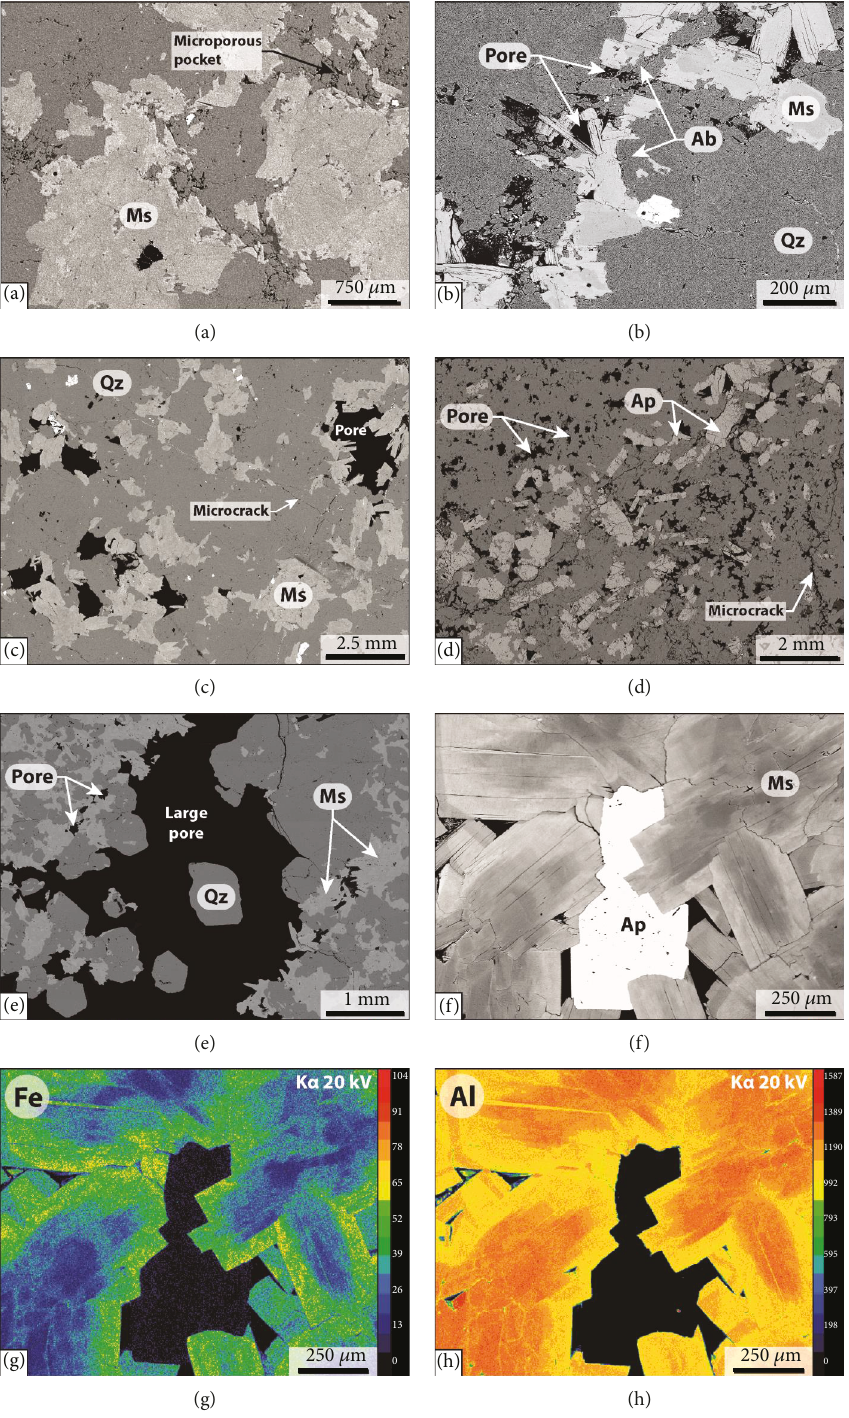
Figure 6: SEM-BSE images displaying the microtextural evolution induced by the greisenization of the Panasqueira granite. (a) Porous texture in a greisenized granite sample showing the heterogeneous distribution of the porosity. A microporous pocket and a microcrack are labeled. (b) Enlargement of a microporous pocket showing the intergranular porosity corresponding to spaces around muscovite grains. (c) Porous texture in greisen showing large pores corresponding to spaces around muscovite grains (this section was made from the sample shown in Figure 2(b), 1). (d) Porous greisen, in which a large amount of hydrothermal apatite has crystallized during the late hydrothermal stages. (e) Large void space fringed by euhedral quartz, which has crystallized from the pore ’ s edge. (f) SEM-BSE image showing hydrothermal overgrowth of muscovite forming greisen and pore space partially in fi lled by hydrothermal apatite. (g) Fe and (h) Al chemical maps prepared from the section shown in (f). Abbreviations from Whitney and Evans [45]. Ab: albite; Ap: apatite; Ms: muscovite; Qz: